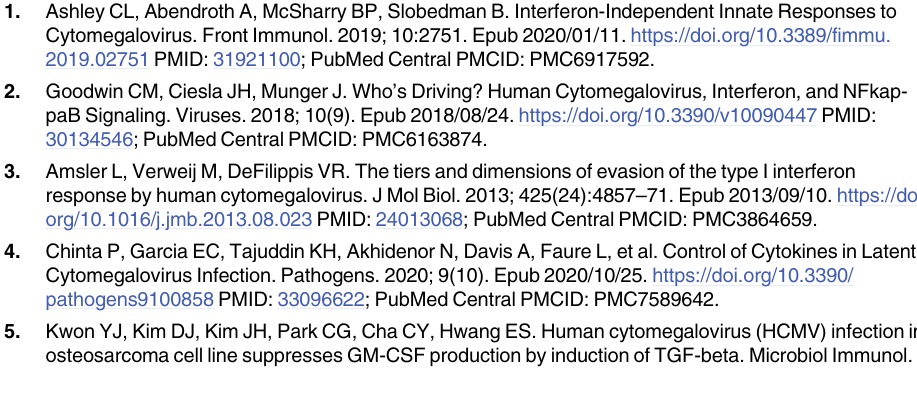
S1 Fig. SMAD3 and IRF7 siRNA reduce target transcript expression in Δ STING, Δ IFNAR and Δ IRF7 cell lines. tHF, Δ STING (A-B), Δ IFNAR (C-D) or Δ IRF7 (E-F) cell lines were transfected with negative control, miR-UL22A mimic or SMAD3 or IRF7 siRNA for 48 hours after which cells were additionally mock transfected or transfected with ISD90 for 16 hours. RNA was isolated and subjected to qRT-PCR for SMAD3 or IRF7. All experiments were per- formed in triplicate. � p < 0.05 by two tailed Student’s t